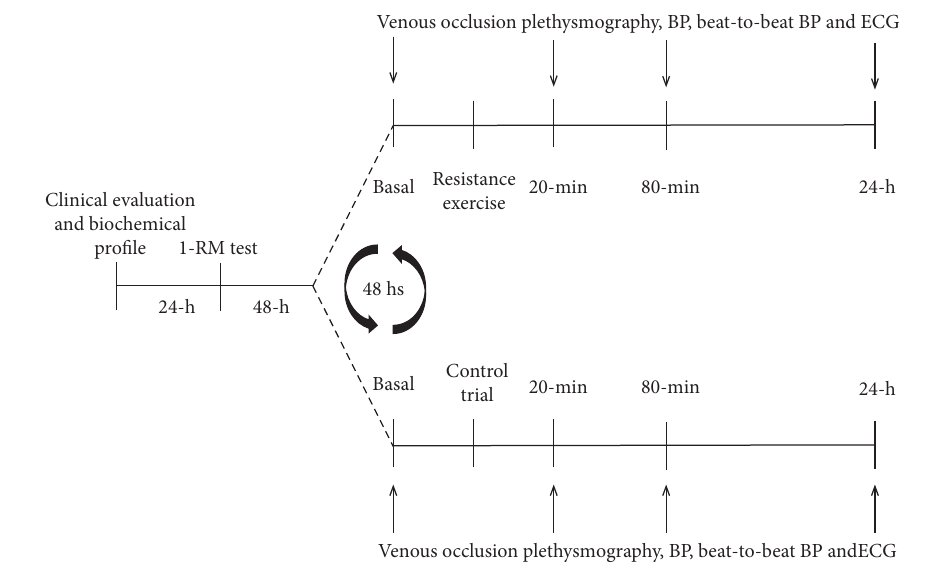
Figure 1: Schematic representation of the experimental